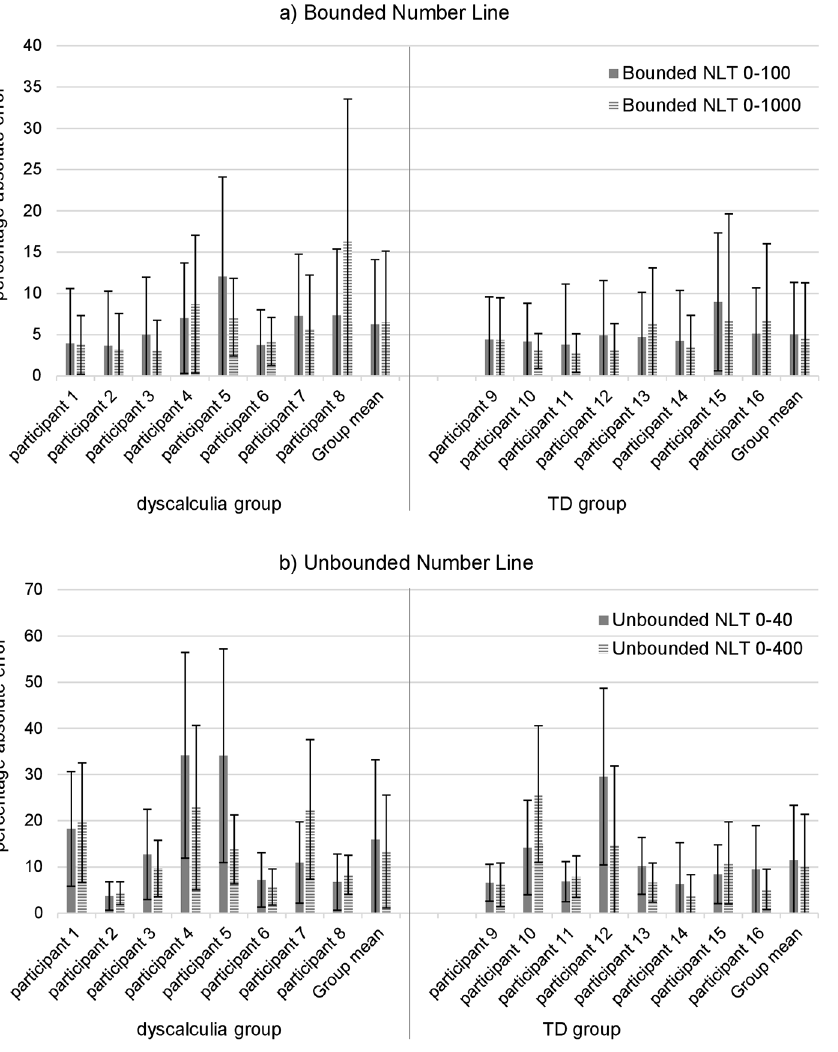
Figure 8. Percentage absolute error per group and per NLT. Error bars display standard deviations in positive and negative